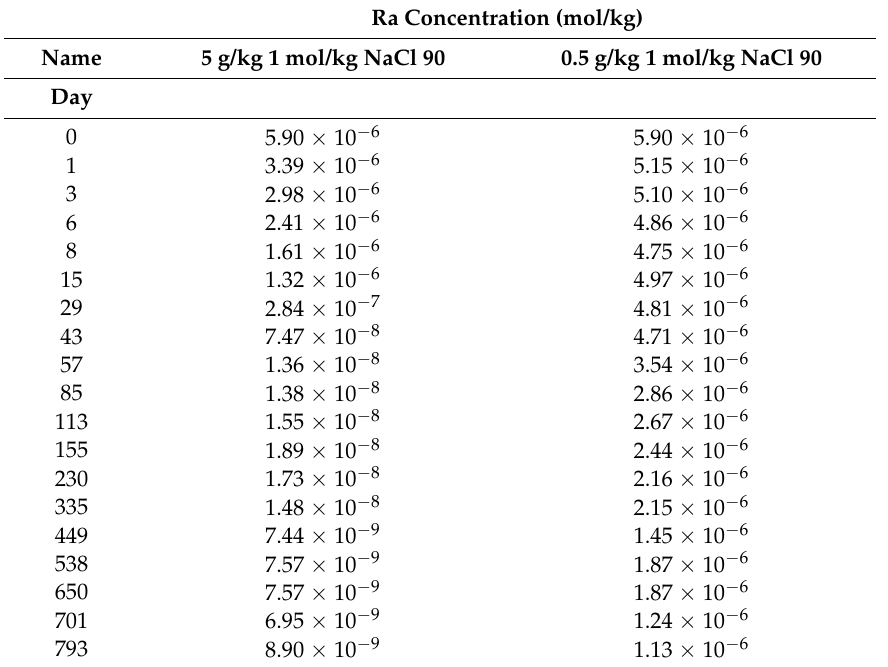
Table A4. Ra concentrations of experiments with 1.0 mol/kg NaCl at 90 ◦ C.